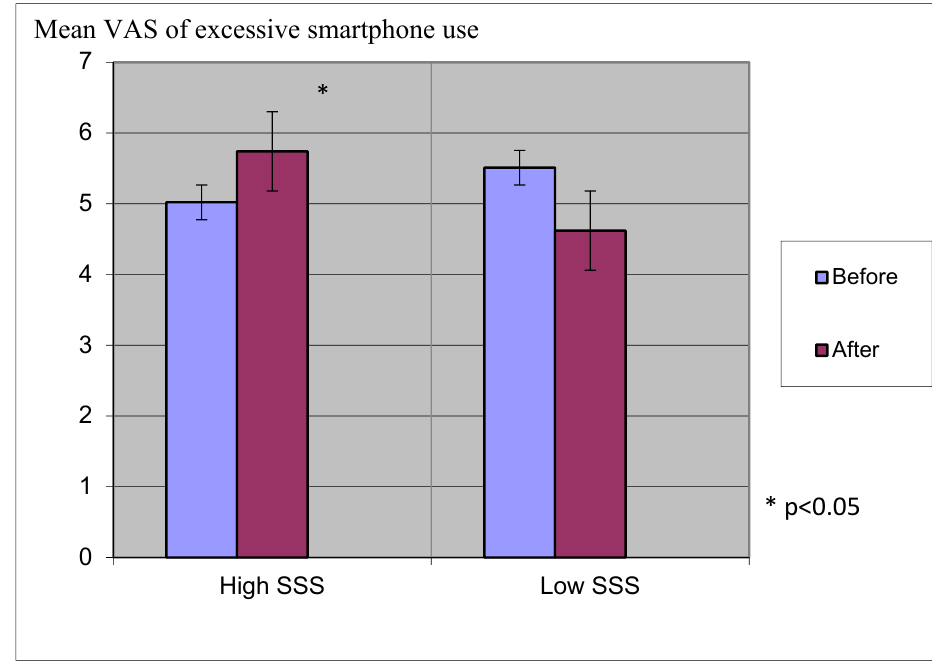
Figure 3. Scores of the smartphone addiction (VAS short) questionnaire, comparing high and low sensation seeking individuals after abstinence from smartphone use. SSS = Sensation Seeking Scale.